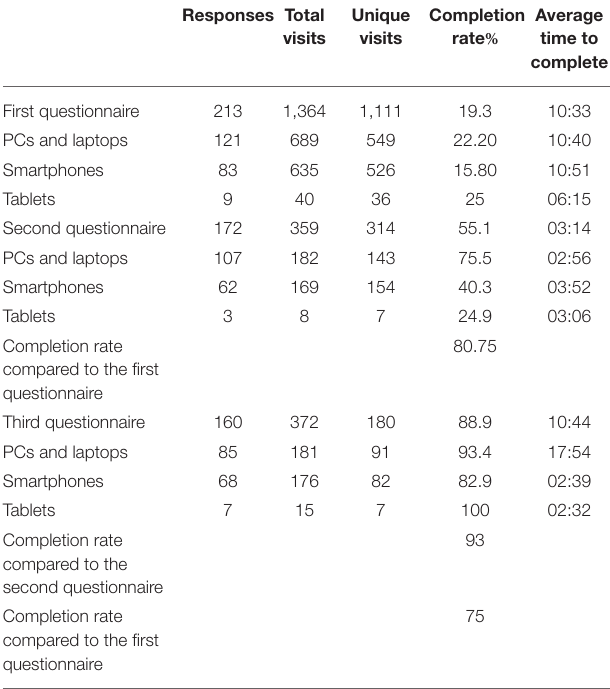
TABLE 3 | Questionnaire participation rates and devices in